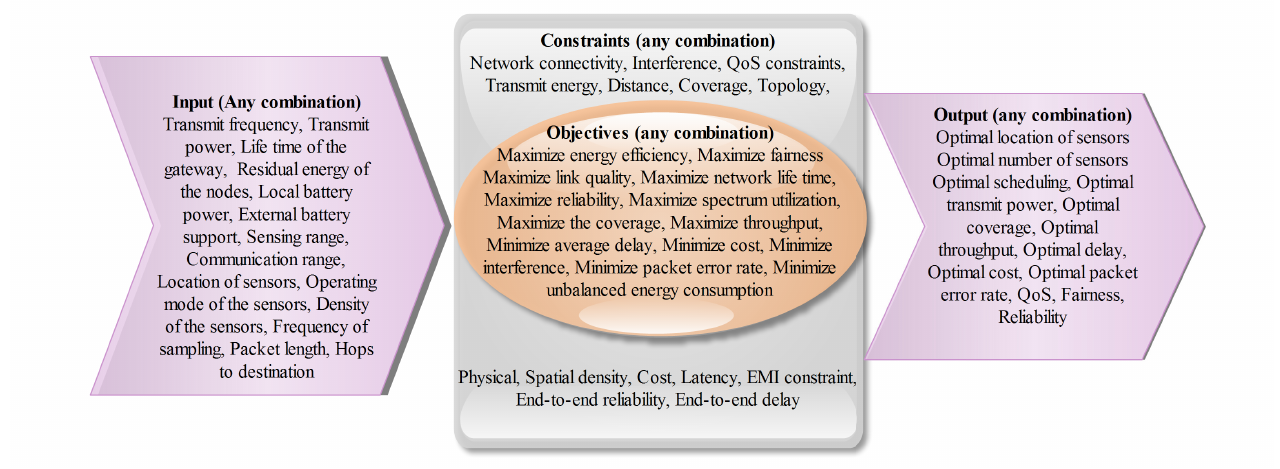
Figure 1. Generic multi-objective optimization problem in wireless sensor networks.